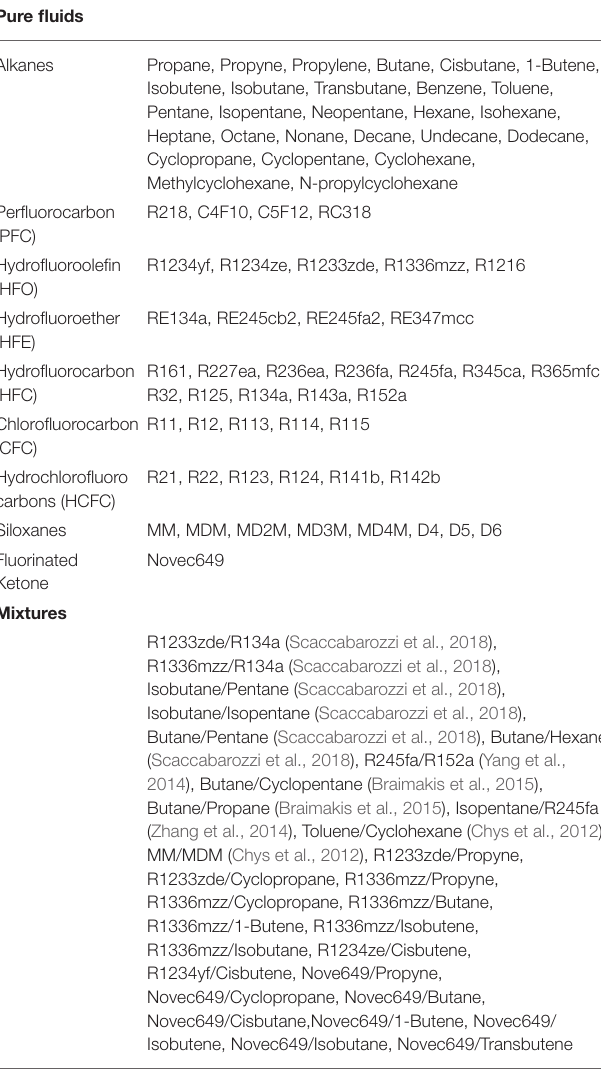
TABLE 1 | List of the pure fluids and mixtures considered in this study. Pure fluids